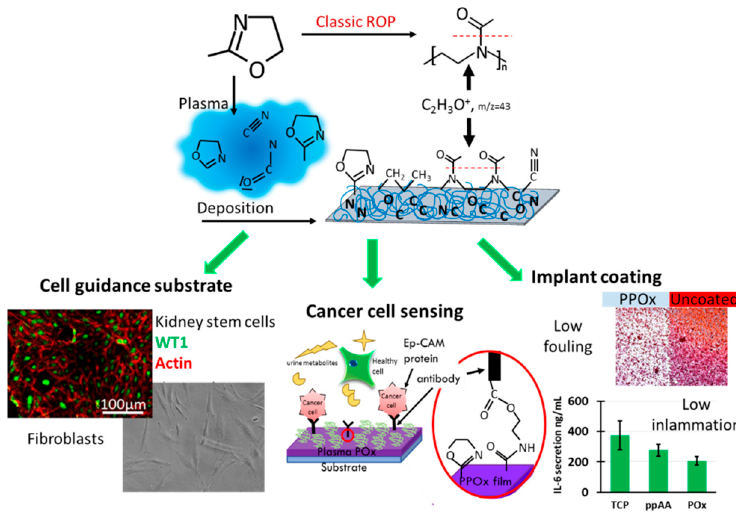
Figure 4. Schematic illustrating the PPox deposition process ( top ) and its applications ( bottom ) for cell guidance surfaces, diagnostic devices and low fouling properties. The left images illustrate the biocompatible nature of PPOx coating on which multiple cell types including human dermal fibroblast and kidney stem cells proliferate as successfully as on tissue culture plate. The middle schematic illustrates the reaction occurring between PPOx and biomolecule with COOH function and how this biofunctionalisation is used for the selective capture of cancer cells. The right-hand side shows the inhibited proliferation of biofilm on PPOx substrates as well as the decrease in pro-inflammatory cytokine IL6 secretion, which together makes PPOx a suitable candidate for implant coatings.